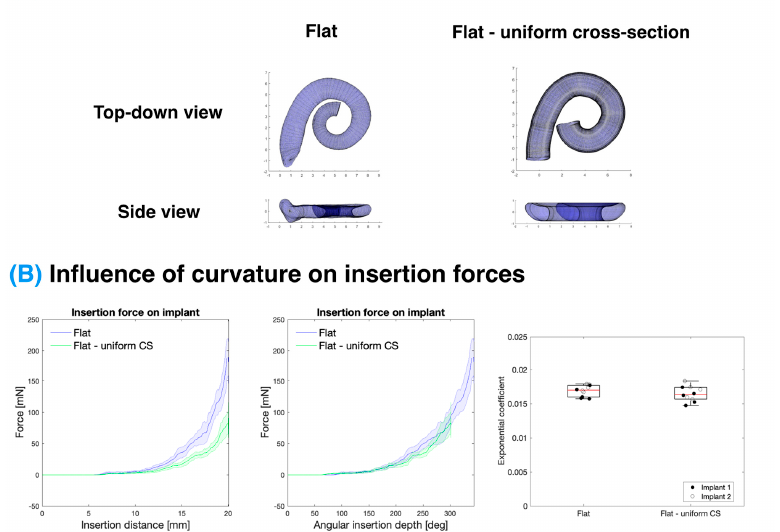
Figure 6. Influence of ST cross-sectional area on insertion forces. ( A ) Manipulation of the ST geometry demonstrating the tapered cross-sectional area of the “flat” model versus the “flat-uniform cross-sectional area” model where the cross-section at 1 mm depth from the round window was used along the same horizontal trajectory. ( B ) Force exerted on the CI during insertion as a function of insertion distance ( left ) and angular insertion depth ( middle ; solid line-mean, shaded area-standard deviation) along with the exponential coefficient of the fitting of the force profiles ( right ; red line-median, box-interquartile range) demonstrates no significant effect ( p > 0.05) of the uniform cross-section area on insertion force. Data represent n = 10 replicates per condition combined over N = 2 implants.